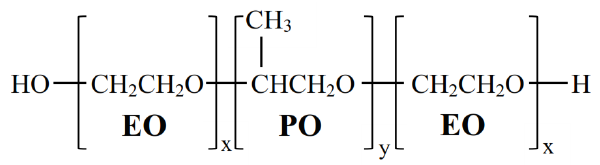
Figure 2. The molecular formula of PF127. x, ethylene oxide (EO) number, y, propylene oxide (PO)